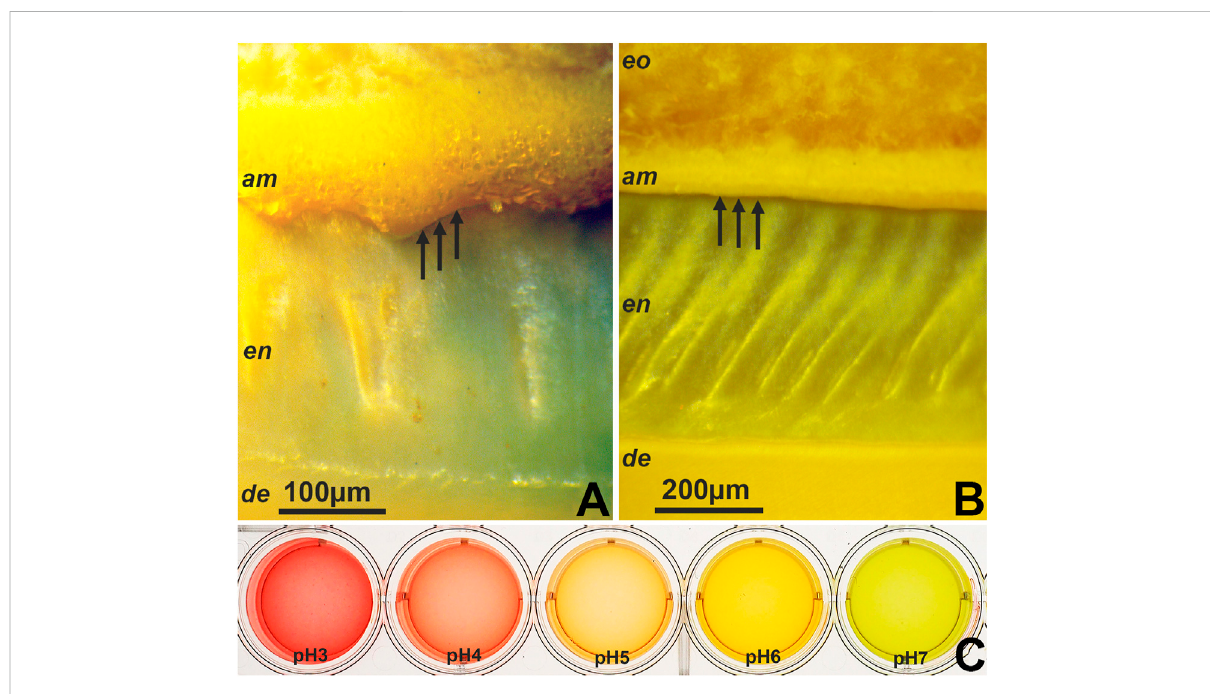
FIGURE 1 Areas of intense pH indicator staining in developing tooth enamel as revealed by pH indicator dyes. (A,B) pH distribution at the exostosis site of secretory ameloblasts and at the ameloblast/enamel interface during secretory stage enamel formation of freshly cut bovine molars. (C)